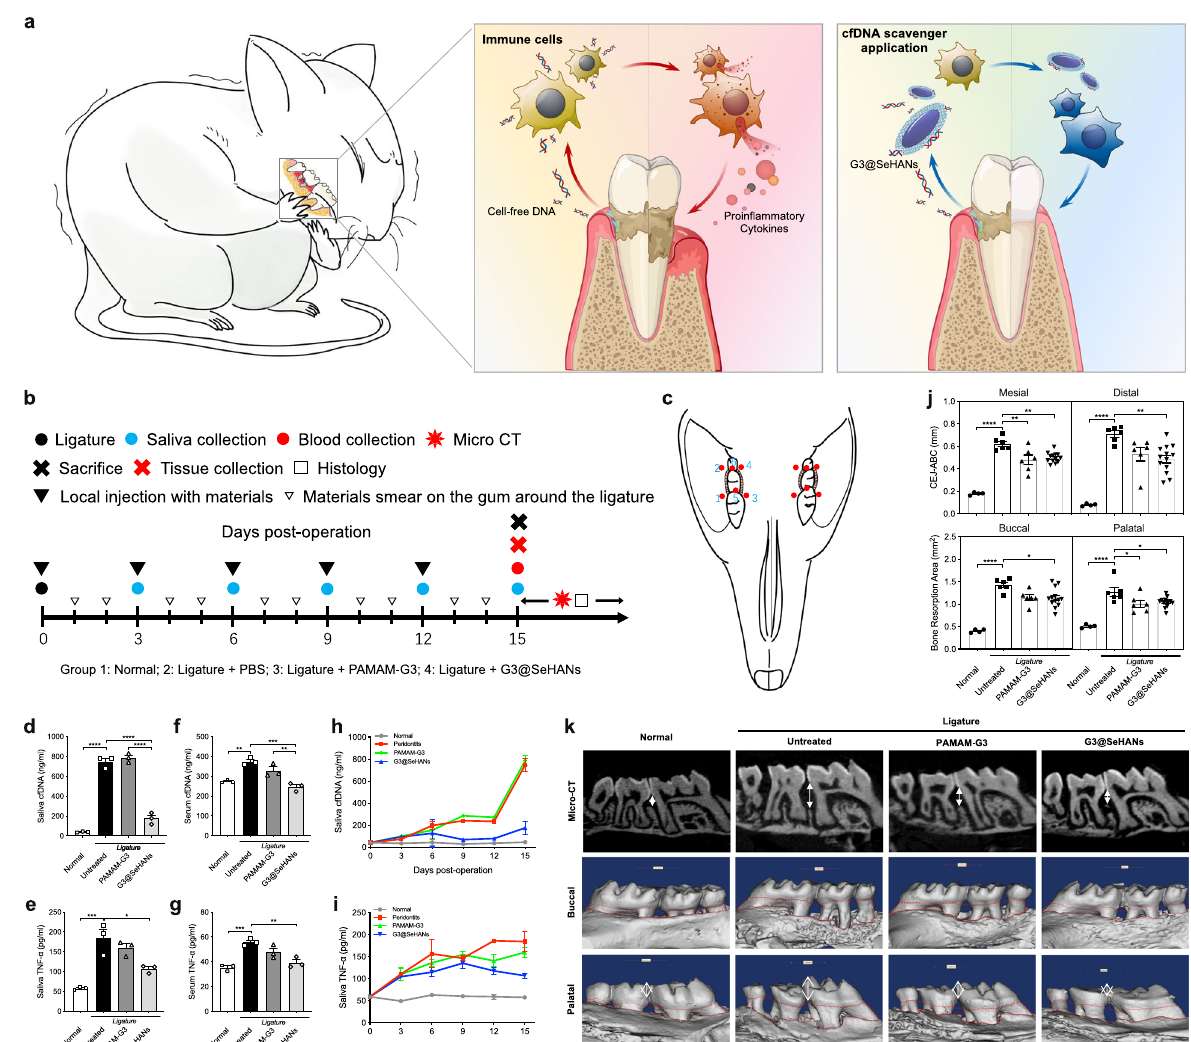
Fig. 5 | G3@SeHANs alleviate in fl ammatory bone loss in ligature-induced per- iodontitis.a SchematicofmechanismbywhichcfDNApromotesboneloss;cfDNA- scavenging nanoparticles may prevent bone loss and alleviate periodontitis. b , c Experimentalscheduleofinvivo study. PAMAM-G3 (200 µ